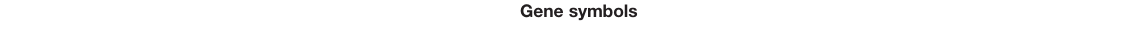
TABLE 5 | Positive and Negative icSARS Gene Panels De fi ned in this Study. icSARS panel